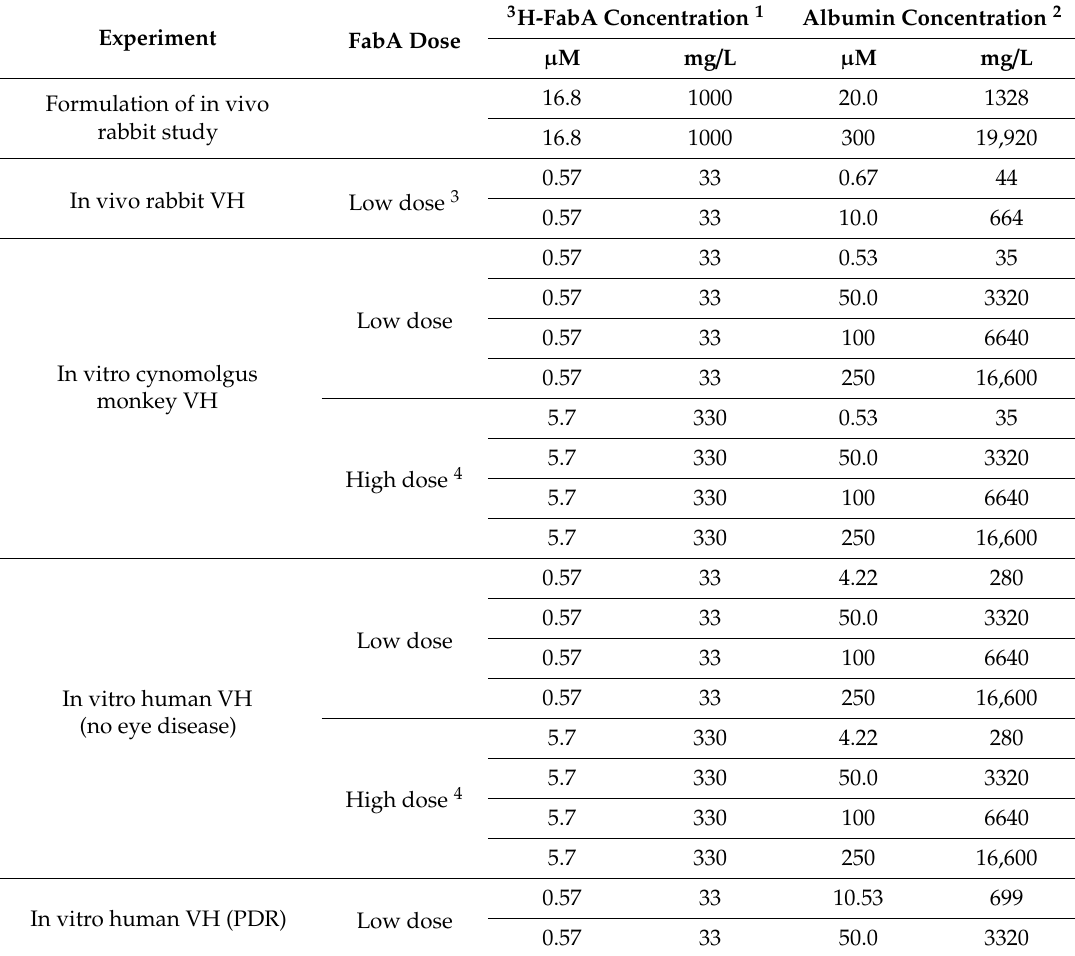
Table 2. List of amounts, volumes and concentrations used in all experiments. Experiment Formulation of in vivo rabbit